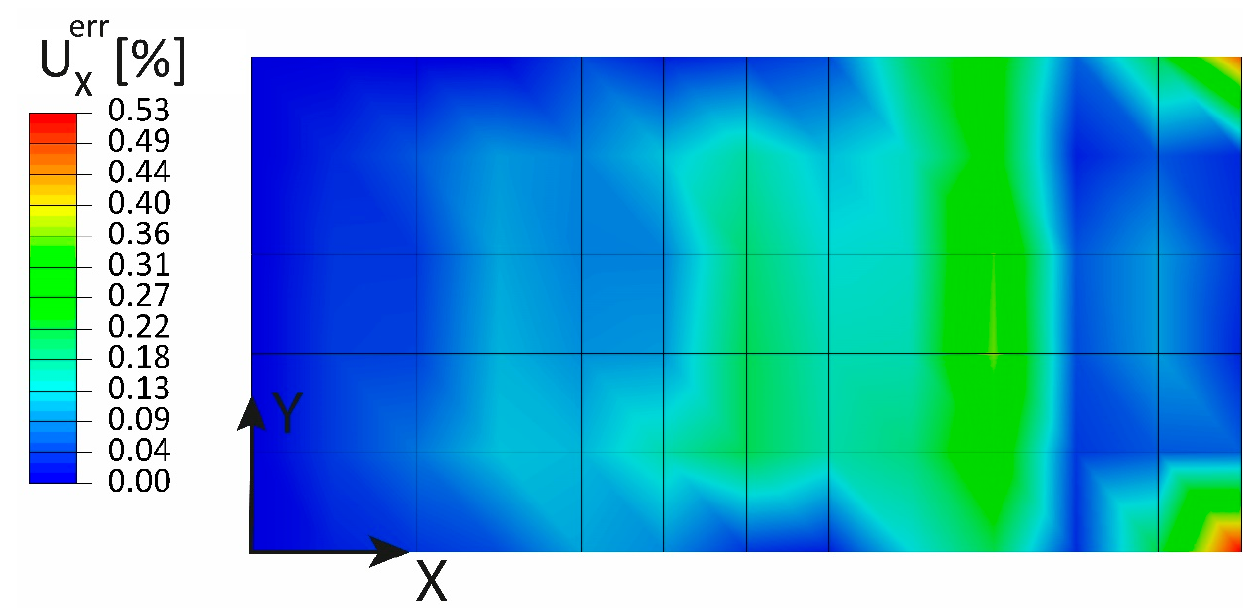
Figure 7 . Traction: ( a ) membrane strain 𝑒 (cid:3025)(cid:3025) and ( b ) normalized membrane strain 𝜂 (cid:3025)(cid:3025) , slice at Y = 250 mm.